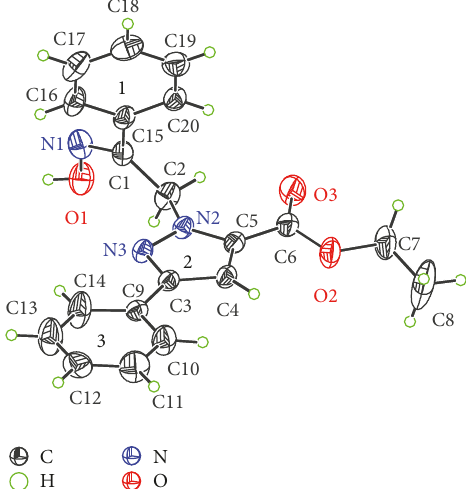
Figure 1: The asymmetrical unit of title compound. Color codes: C (gray), O (red), N (blue), and H (green). Displacement ellipsoids are drawn at the 30% probability level.